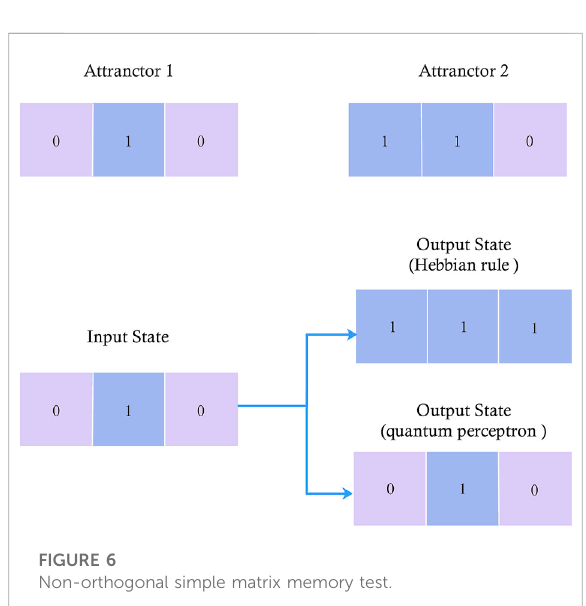
FIGURE 6 Non-orthogonal simple matrix memory